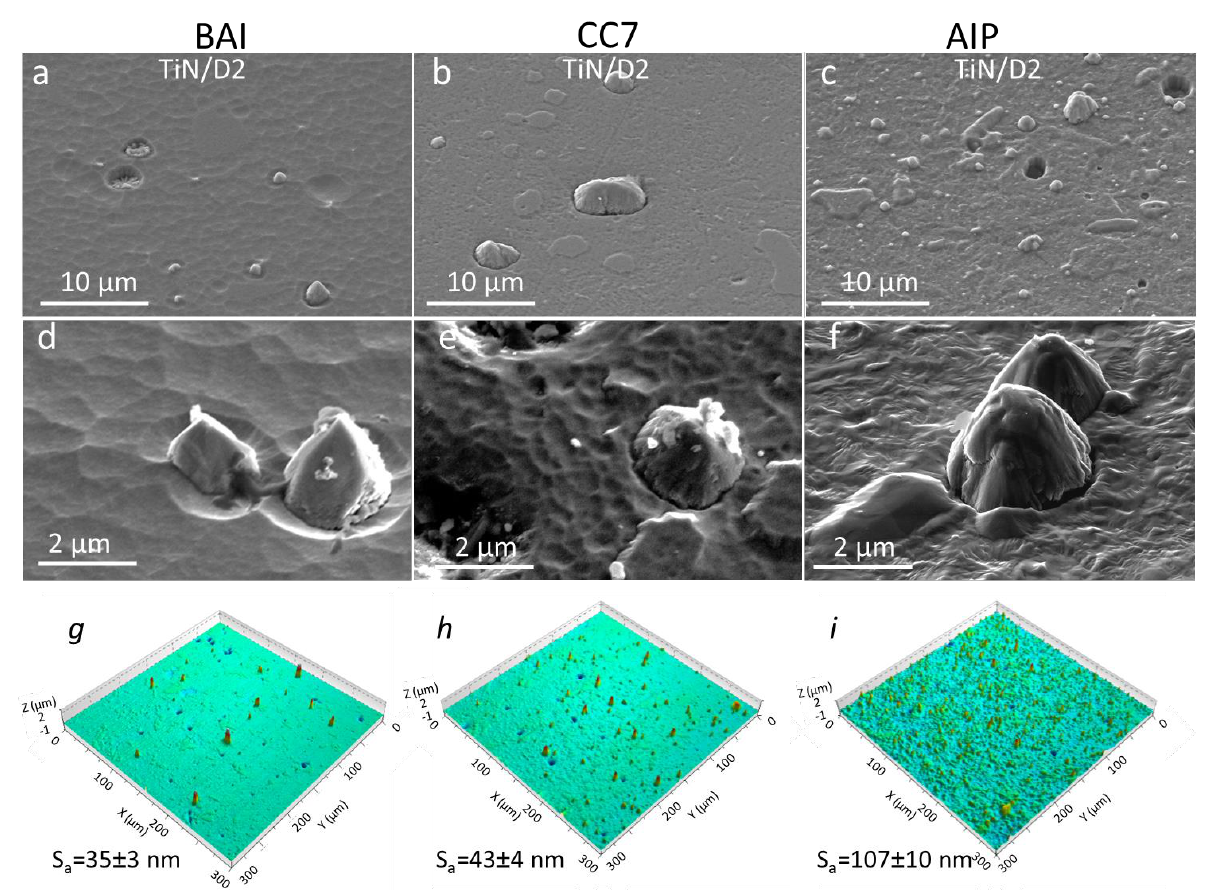
Figure 23. Top view SEM images at lower ( a – c ) and higher ( d – f ) magnifications and 3D surface profile images ( g – i ) of TiN coating deposited on D2 tool steel substrate using BAI, CC7 and AIP deposition systems. The SEM images are the side view from about 45° inclined direction. The sharp peaks in 3D surface profile images are the nodular defects while the blue dots are craters.